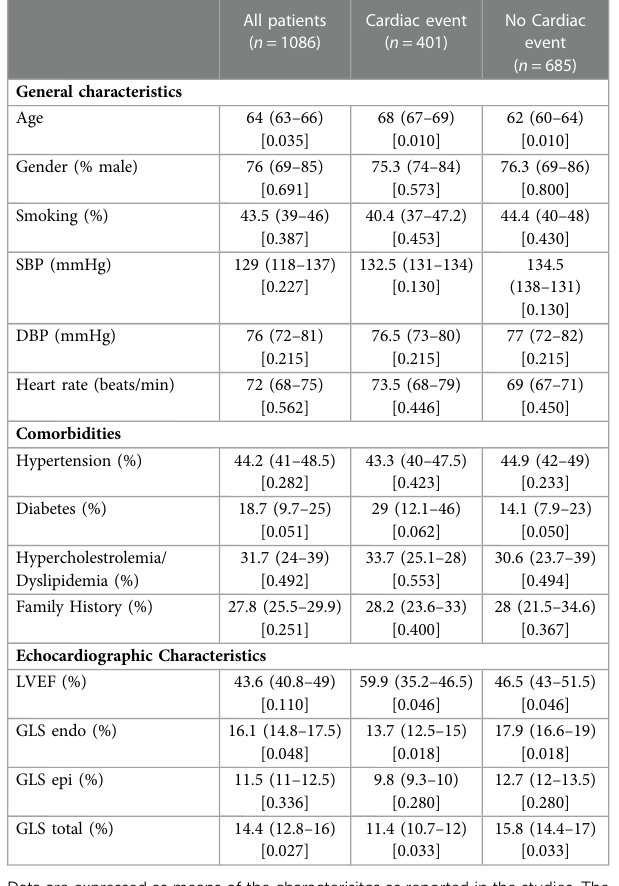
All patients ( n =1086)